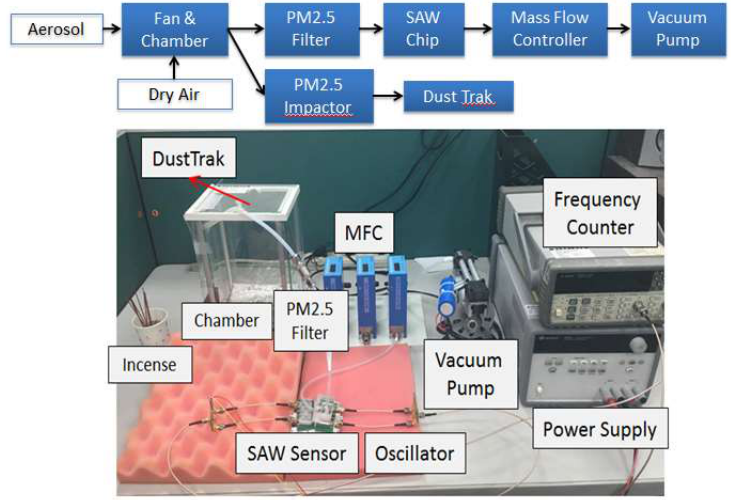
Figure 5. Experimental setup.